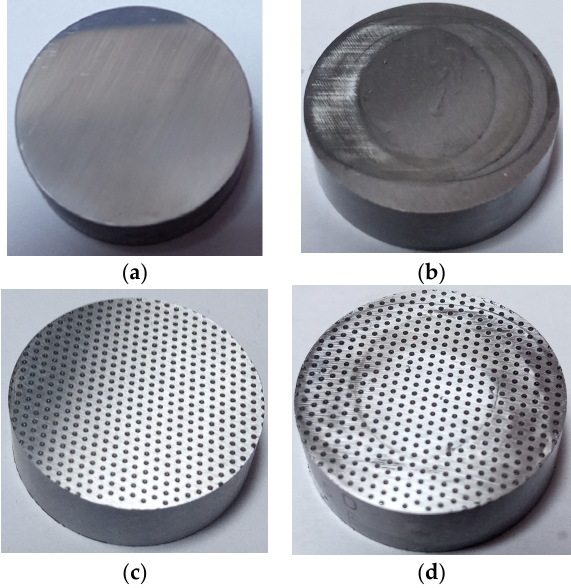
Figure 13. Photo of the untextured disc before the test ( a ), photo of untextured disc after the test with oil and wear products ( b ), photo of textured disc with pit/area ratio of 25% before the test ( c ), oil and wear products ( b ), photo of textured disc with pit area ratio of 25% before the test ( c ), and and photo of textured disc with pit/area ratio of 25% after the test with oil and wear products ( d ). photo of textured disc with pit area ratio of 25% after the test with oil and wear products ( d